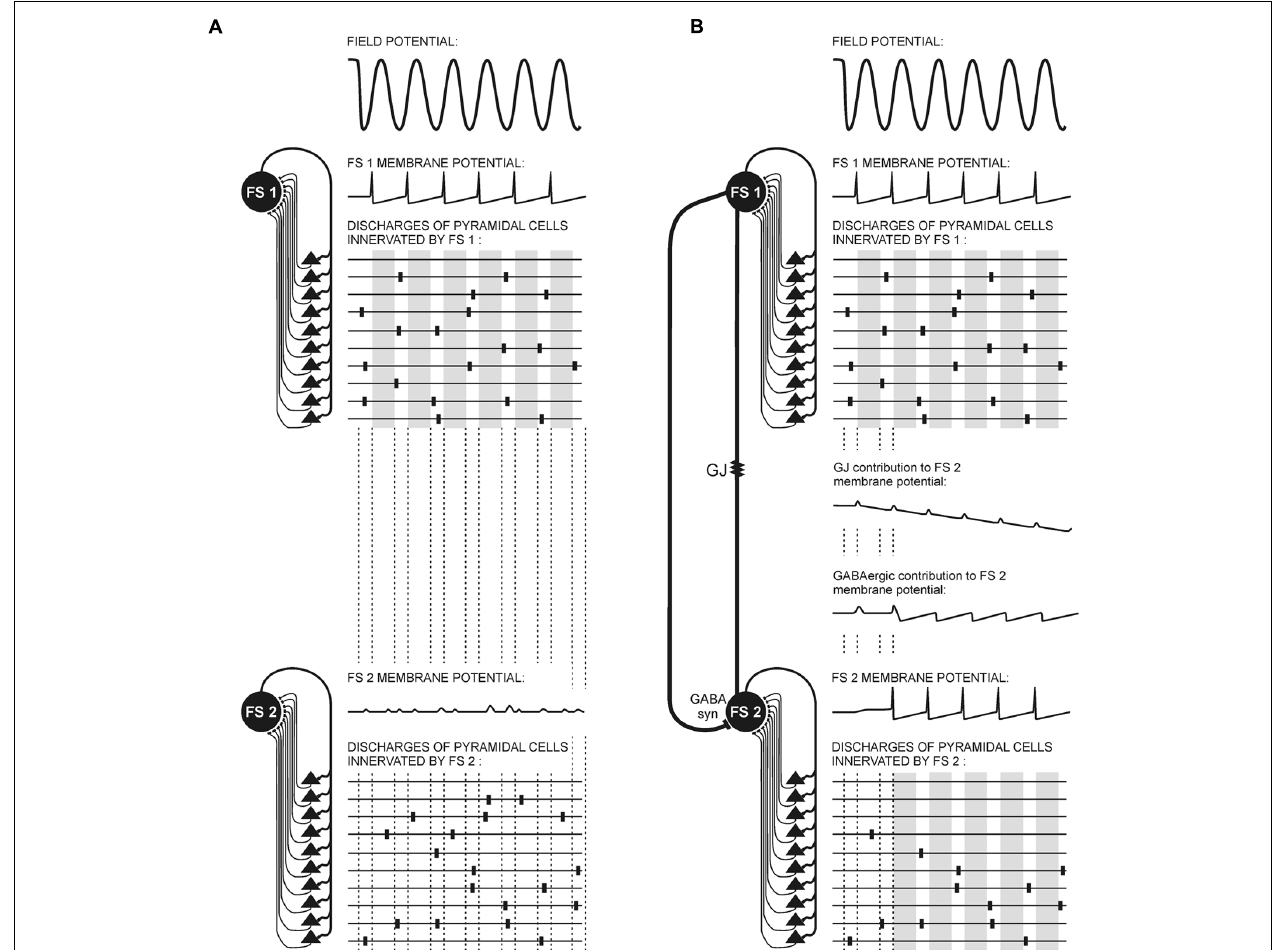
containing Cx36 subunit (GJ) and a GABAergic synapse (GABA syn). FS 2 receives subthreshold coherent inputs from the same portion of pyramidal cells as in (A) , but it also receives coherent inputs from FS 1 mediated by the GABAergic synapse and the GJ. Summation of those coherent inputs results in rhythmical discharges of FS 2. The activity of pyramidal cells connected with FS 2 receiving non-coherent afferent inputs is attenuated. Notice the different dynamics of potentials mediated through the GJ and GABAergic synapse. Hyperpolarizing phases of GJ potential are slow. They summate, providing a long-lasting decrease in FS 2 membrane excitability and prevent FS 2 burst firing. Contrarily, inhibition provided by the GABAergic synapse between FS cells is very fast, and it precisely harmonizes the activity of FS cells. Alternatively, GABAergic synapses can transmit depolarizing currents to the FS cell when it is activated only at the moderate level and does not discharge (so long as its membrane potential does not achieve − 55 mV). The small-amplitude depolarizing phase of potential mediated by the GJ almost coincides with FS 1